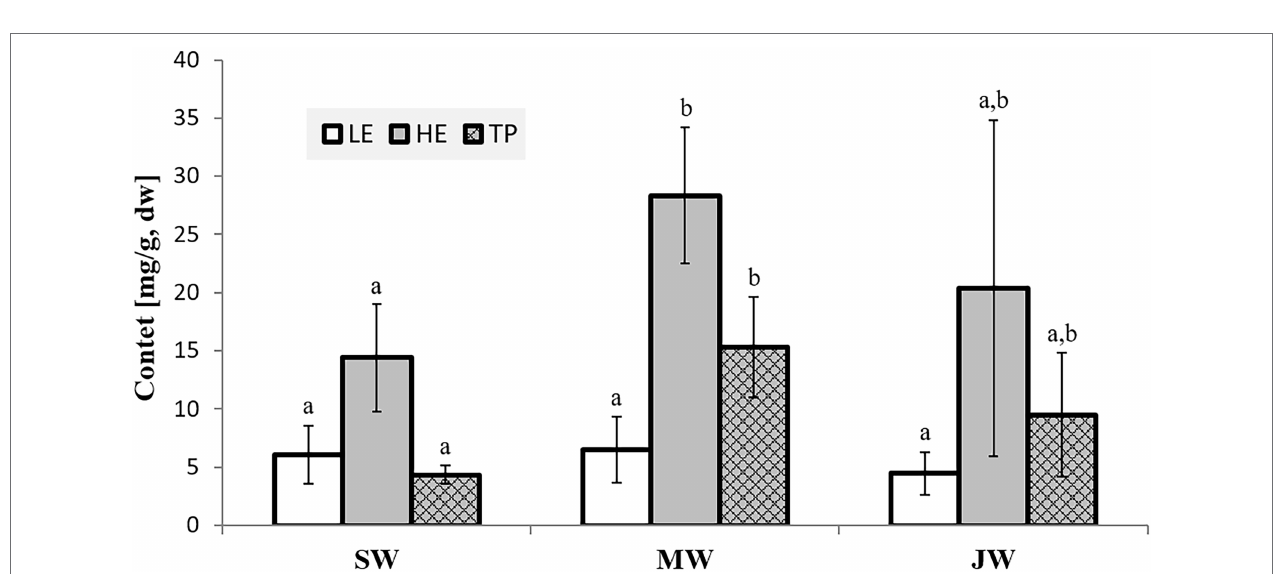
FIGURE 4 | Content of in cyclohexane soluble compounds (LE, lipophilic extractives), in acetone soluble compounds (HE, hydrophilic extractives) and content of total phenolic compounds (TP) in the wood of Douglas fir ( Pseudotsuga menziesii ). Different letters on the top of the error bars indicate statistically significant differences at 95% confidence level. SW, sapwood; aHW, adult heartwood; jHW, juvenile